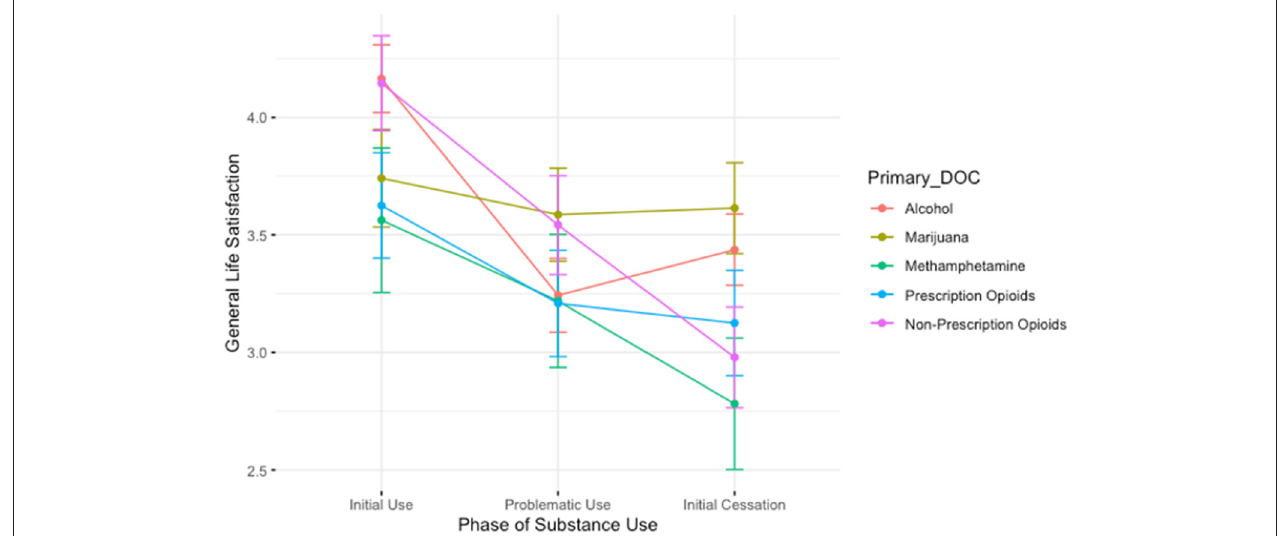
FIGURE 6 | A plot showing the average general life satisfaction scores for participants during the initial stages of use, the height of problematic use, and during the initial stages of cessation. Lines are colored by participant primary substance of choice. Those who used marijuana report higher general life satisfaction than those who used alcohol during the height of problematic